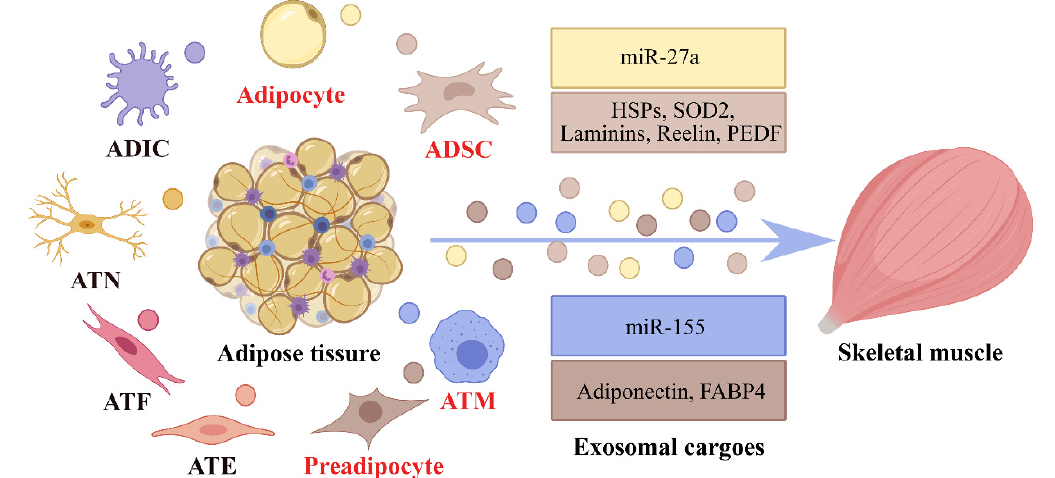
Figure 2. The crosstalk between adipose tissure and skeletal muscle through the adipose-derived exosomes. ADSC: AT-derived stem cell; ATM: AT macrophage; ATE: AT endotheliocyte; ATF: AT fibroblast; ATN: AT neurocyte; ADIC: AT immune cell.